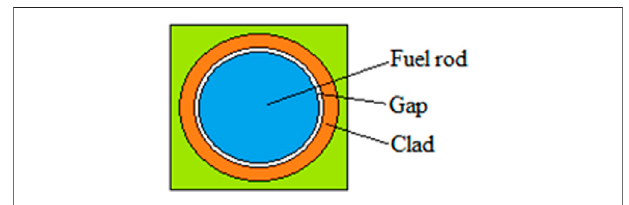
FIGURE 3 | Pin cell geometry of the designed BWR system in